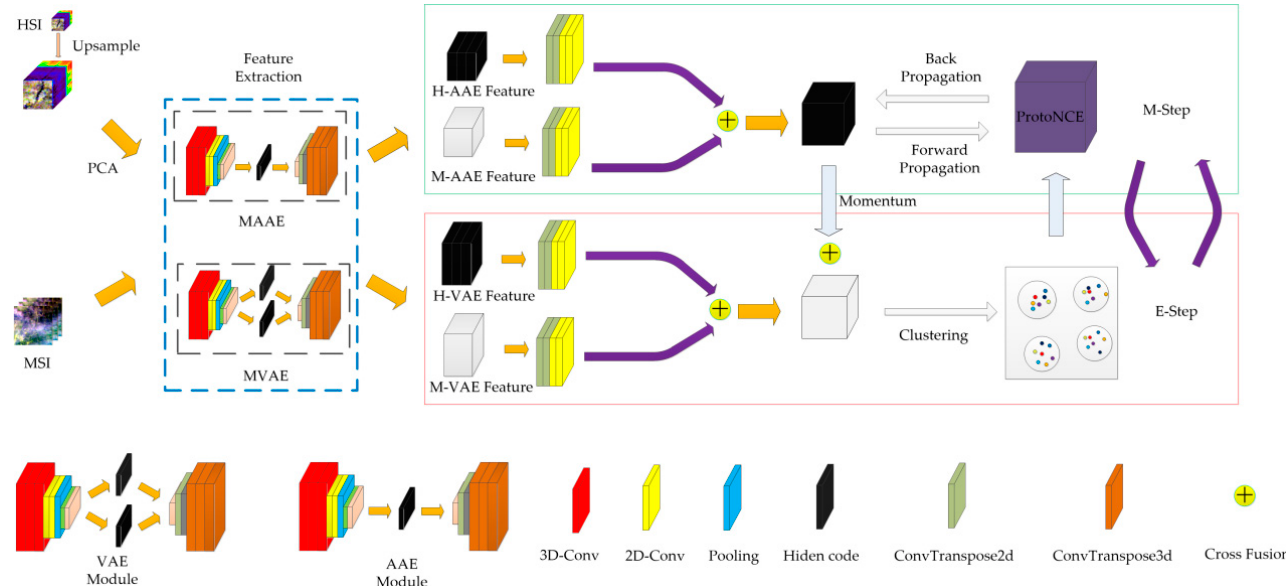
Figure 5. The architecture of the M-SSL for tree species classification.